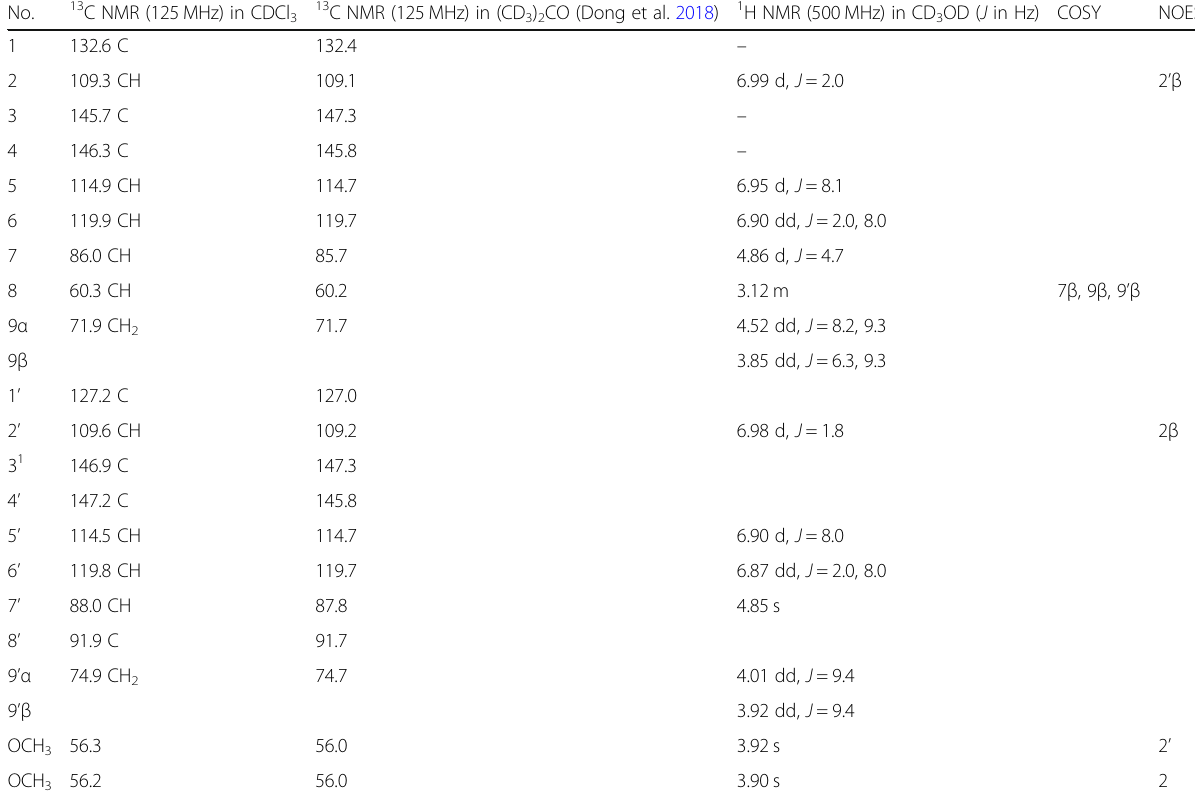
Table 1 Correlation table for NMR data of compound 8: (-)-8-hydroxypinoresinol No.